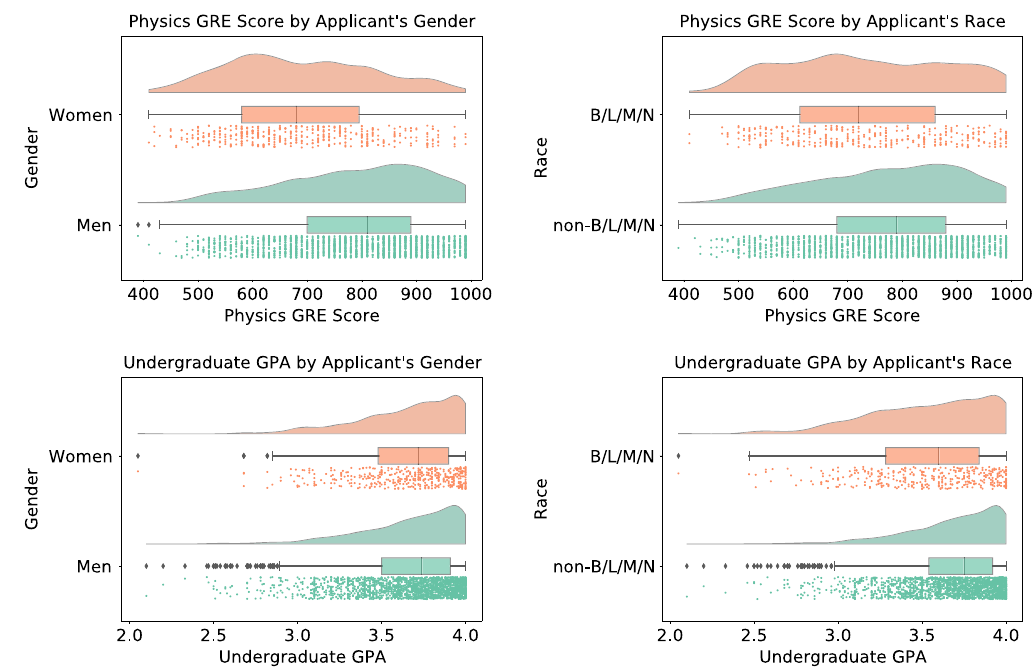
FIG. 18. Distribution of physics GRE scores and undergraduate GPAs by gender and whether the applicant identified as a member of a racial or ethnic group currently underrepresented in